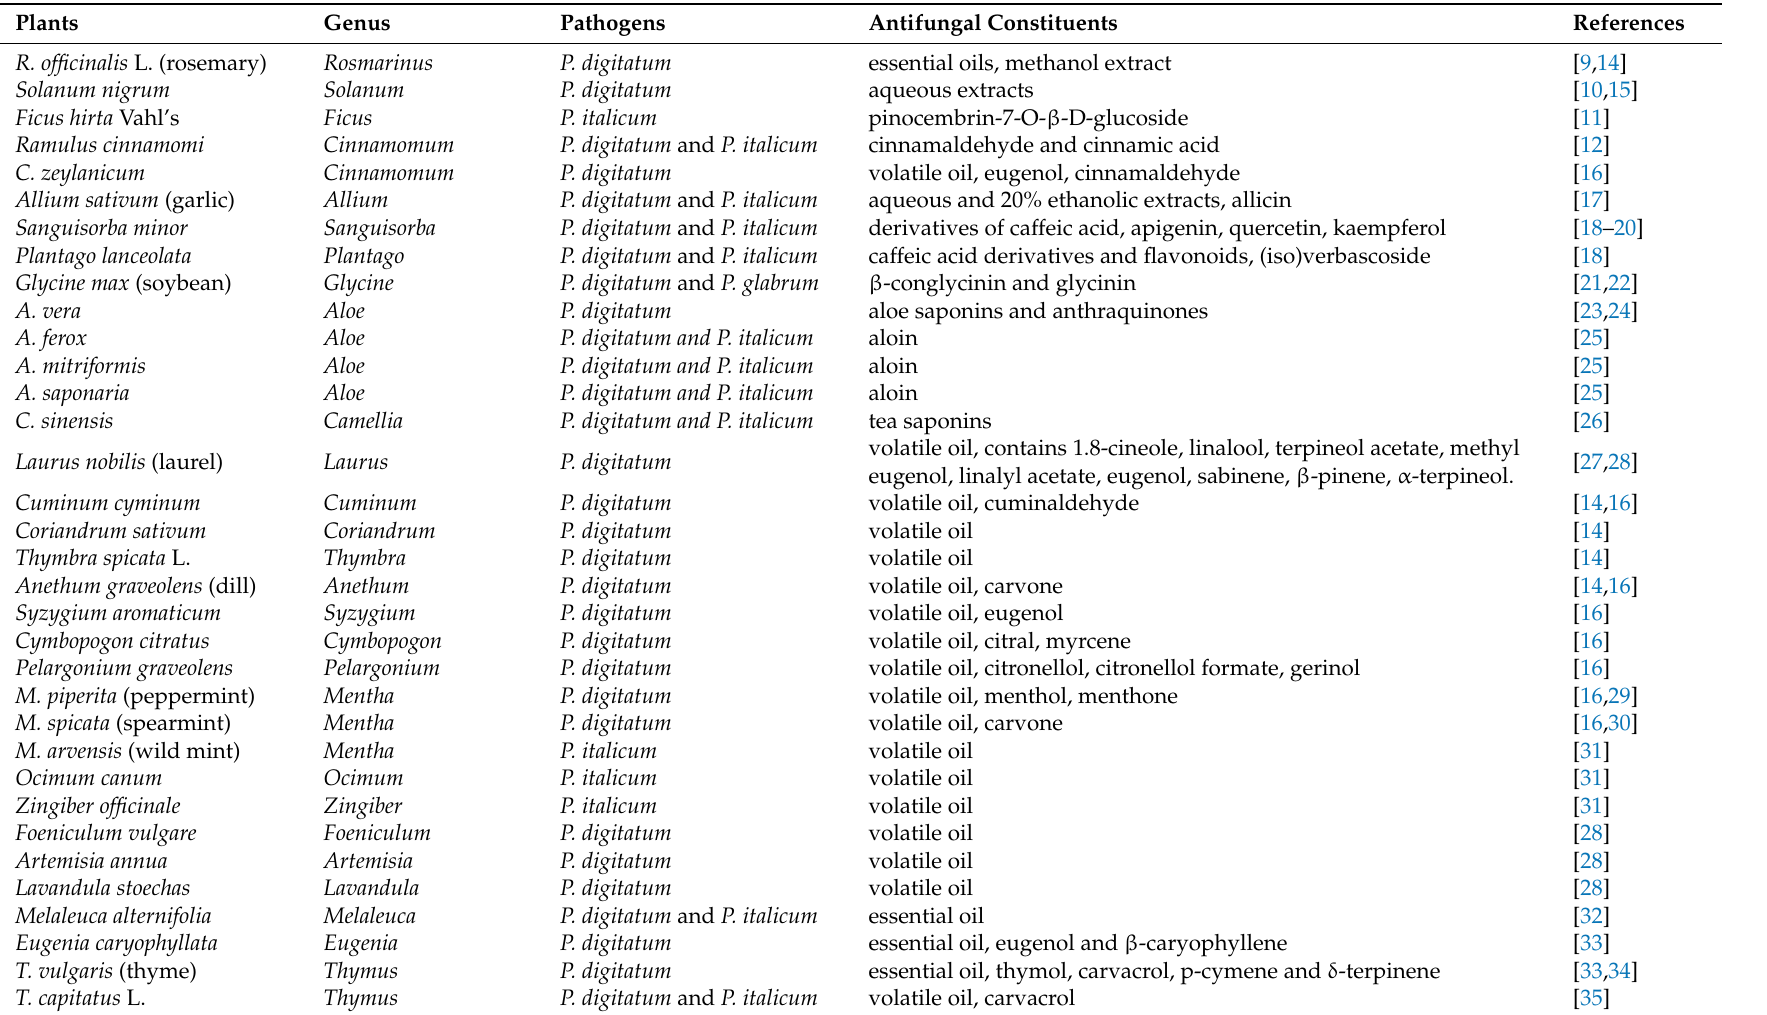
Table 1. Inhibitory activity of plant extracts on P. digitatum and P. italicum